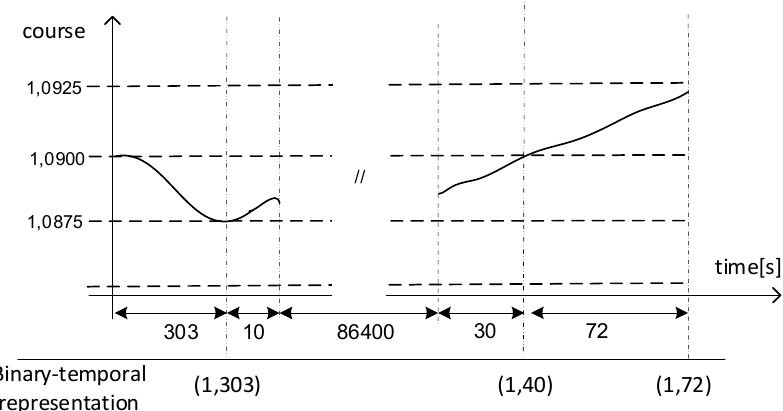
Figure 8. Binary-temporal representation algorithm’s performance during a price gap. 5.2. Application of the Binary-Temporal Representation The binary-temporal representation can be used in order to effectively model exchange rates. The appointed discretization unit stands as a filter which eliminates changes of a very small range. As an example, using the smallest discretization unit we obtain tick data but without the identical quotations repeated several times. Appointing higher values of the discretization units leads, on the other hand, to elimination of information about the changes of a smaller range, including the noise. With the increase of the applied discretization unit, the loss of informative value is getting higher (Stasiak 2018). However, the most important thing is that contrary to the candlestick representation, the level of the informative value can always be specified, since each change of the size bigger than the DU will not be omitted. This stands as the most important difference between the binary-temporal and candlestick representation. In the context of analyzing a particular financial instrument, research of a vast spectrum of discretization units is justified. Based on this, one can appoint the change range limit that limits the noise and one can chose optimal discretization unit for the given market. Using the binary representation allows for a renewed verification of many assumptions and hypotheses encountered in scientific research since way back, which were not credibly verified because of the defects of the candlestick representation (or its short version, e.g., only the opening prices). That kind of research can be burdened with significant errors (Examples 3 – 5).